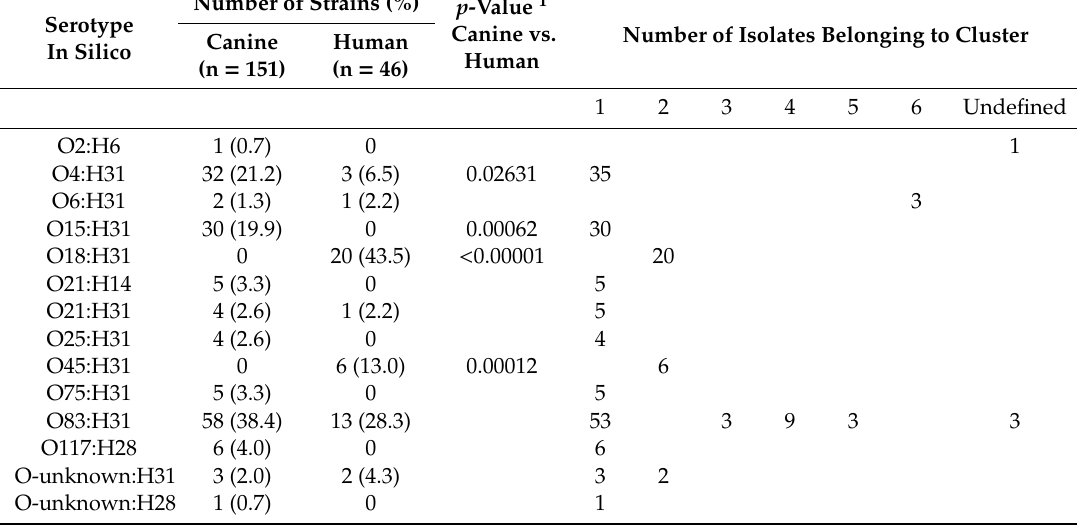
Table 8. Distribution of serotypes among the 197 ST372 strains according to origins (canine and human) and cluster types.